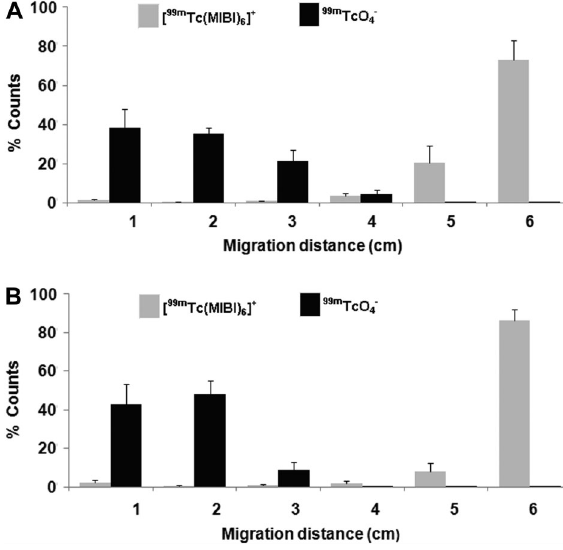
Figure 4. Paper chromatography of 99m TcO 4– and [ 99m Tc(MIBI) 6 ] + in Whatman 1 (W1) regular paper ( A ) and W1 modified paper ( B ) reported as percent of counts in segments of the chromatographic strip (cm), numbers 1 to 6. Anhydrous ethanol was used as the mobile phase. W1 modified paper is W1 paper washed with anhydrous ethanol. Data are reported as means±SD for n=18 ( A ) or n=11 ( B